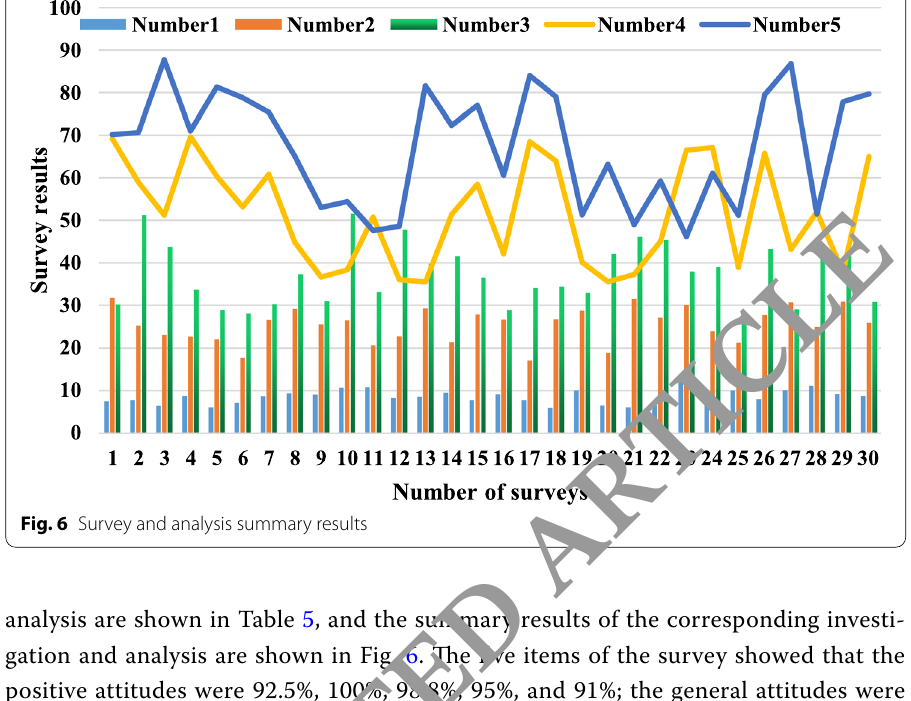
Fig. 6 Survey and analysis summary